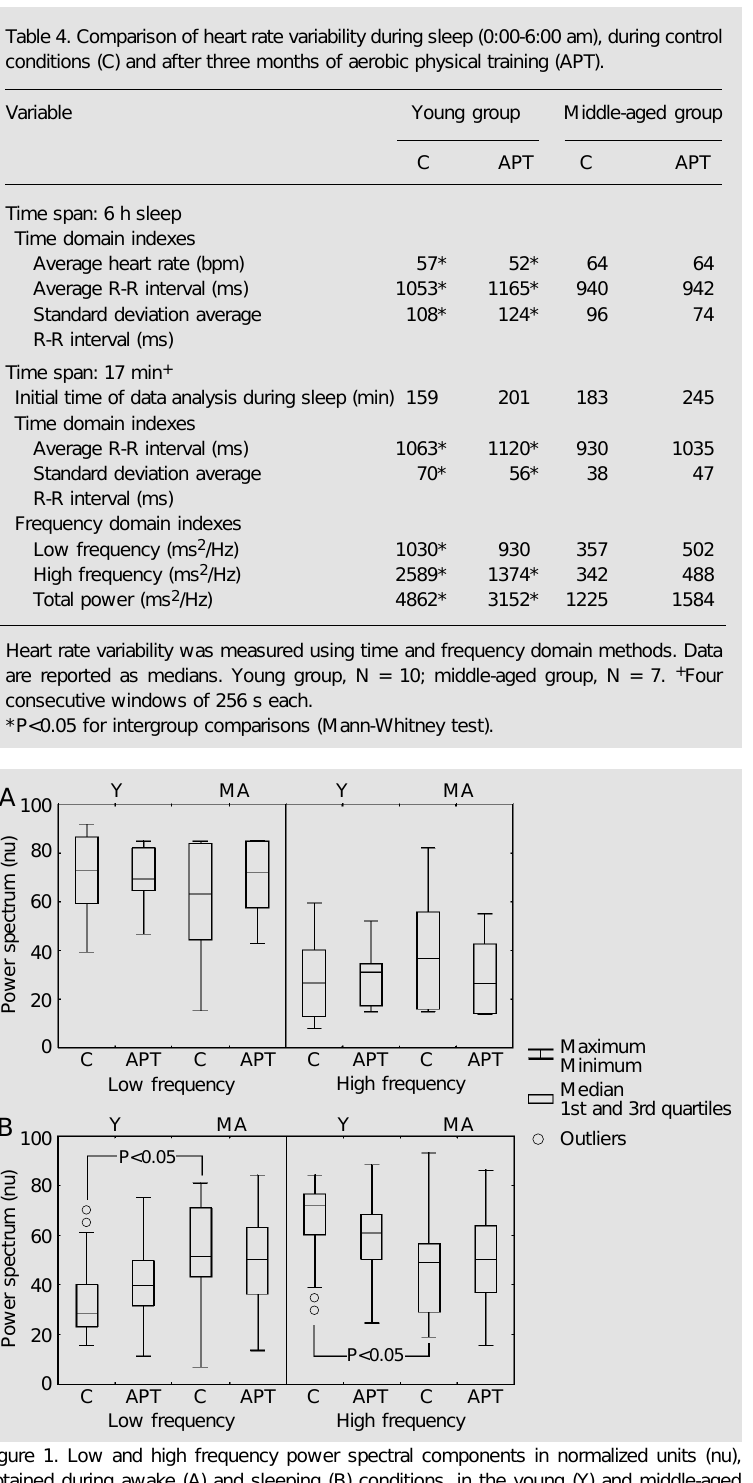
Table 4. Comparison of heart rate variability during sleep (0:00-6:00 am), during control conditions (C) and after three months of aerobic physical training (APT).